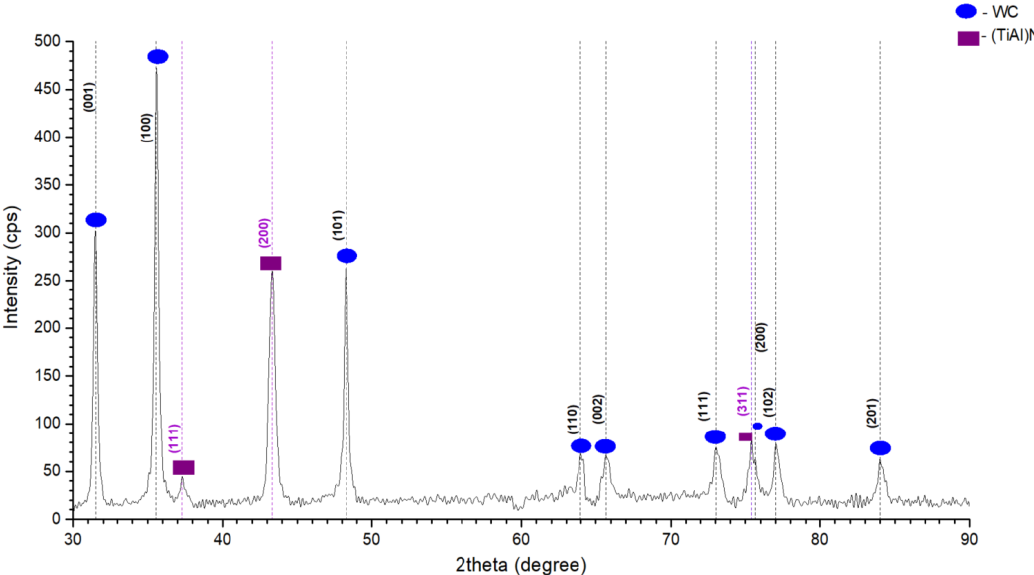
Figure 6. The representative XRD patterns of the MCT-TAN specimen.